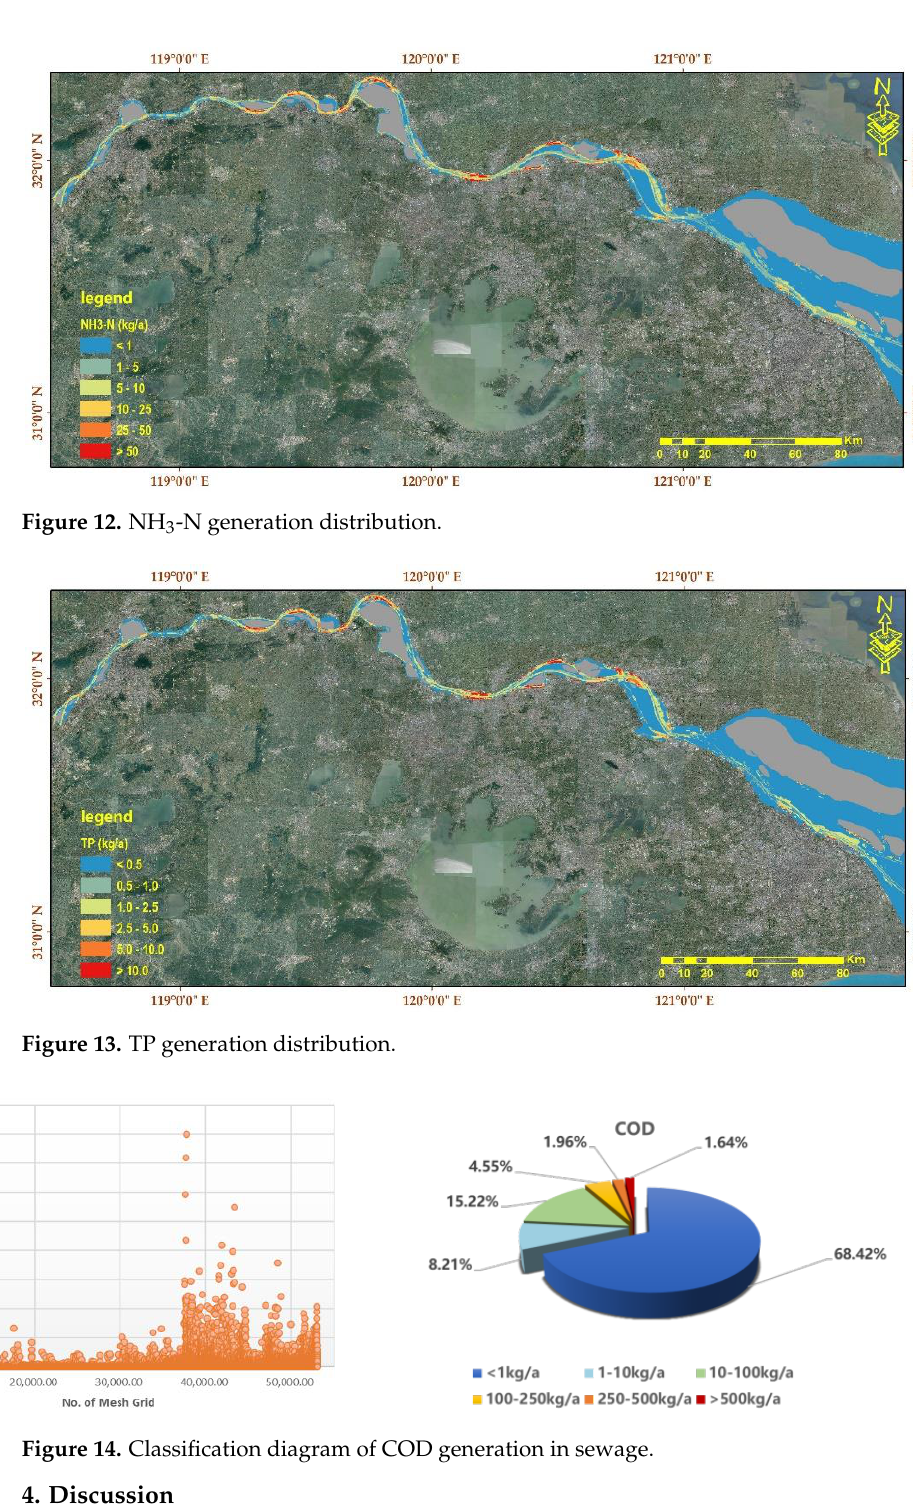
Figure 11. TN generation distribution.